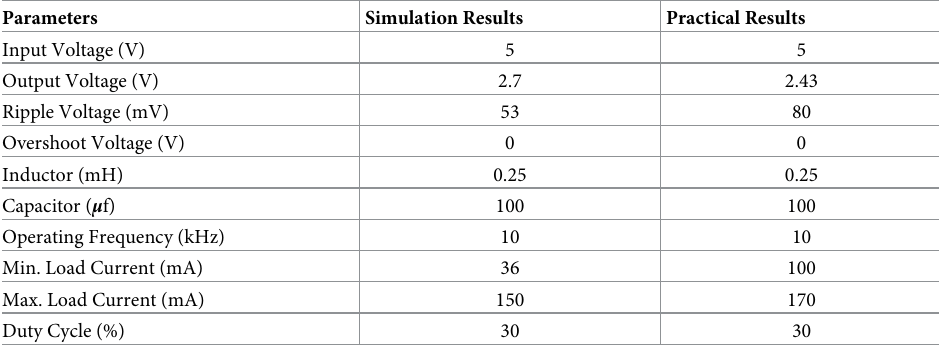
Table 4. Comparison of simulation model results with that of practical lab results.